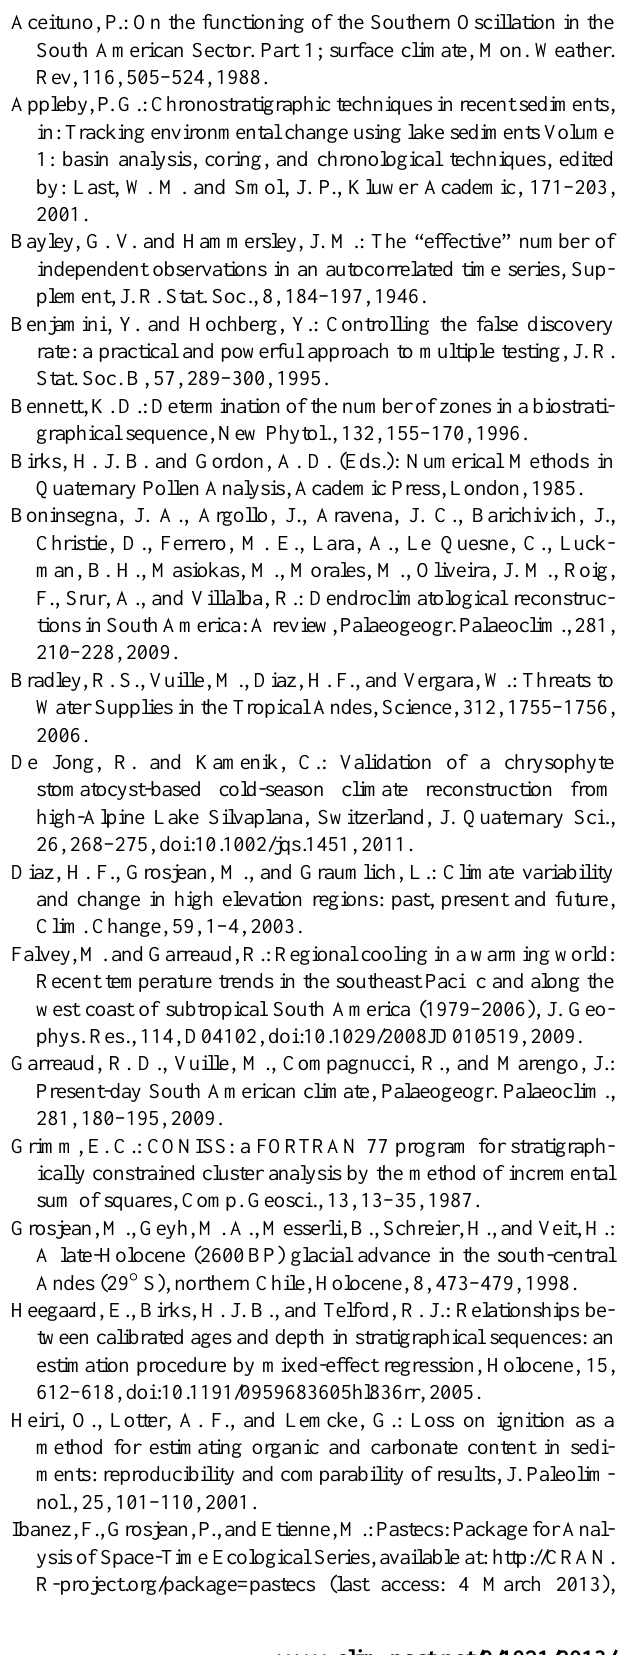
Fig. 1. Total biogenic silica was measured at the Paul Scherrer Institute (Villigen) and gamma decay counts of 210 Pb, 137 Cs and 226 Ra were measured at EAWAG, Dübendorf. Radiocarbon ages were determined at the Poznan Radiocarbon Laboratory.